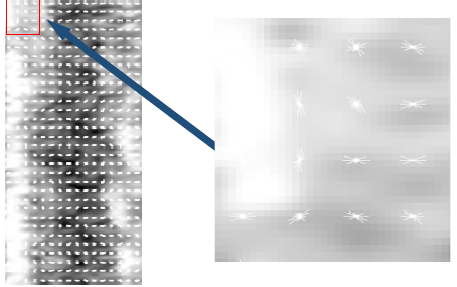
Figure 15. Feature extraction using histogram of oriented gradient (HOG) algorithm.